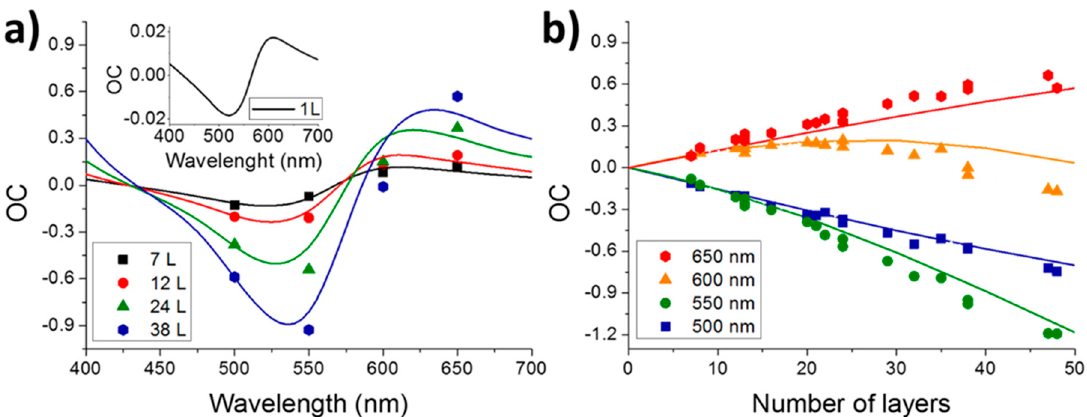
Figure 2. ( a ) Wavelength dependent optical contrast (OC) for hBN thicknesses from 7 to 38 monolayers (L) and a single monolayer (inset) deposited on a 290 nm SiO 2 / Si substrate. ( b ) OC of hBN on a 290 nm SiO 2 / Si substrate as a function of the number of layers. Experimental OC values represent symbols and theoretical lines.